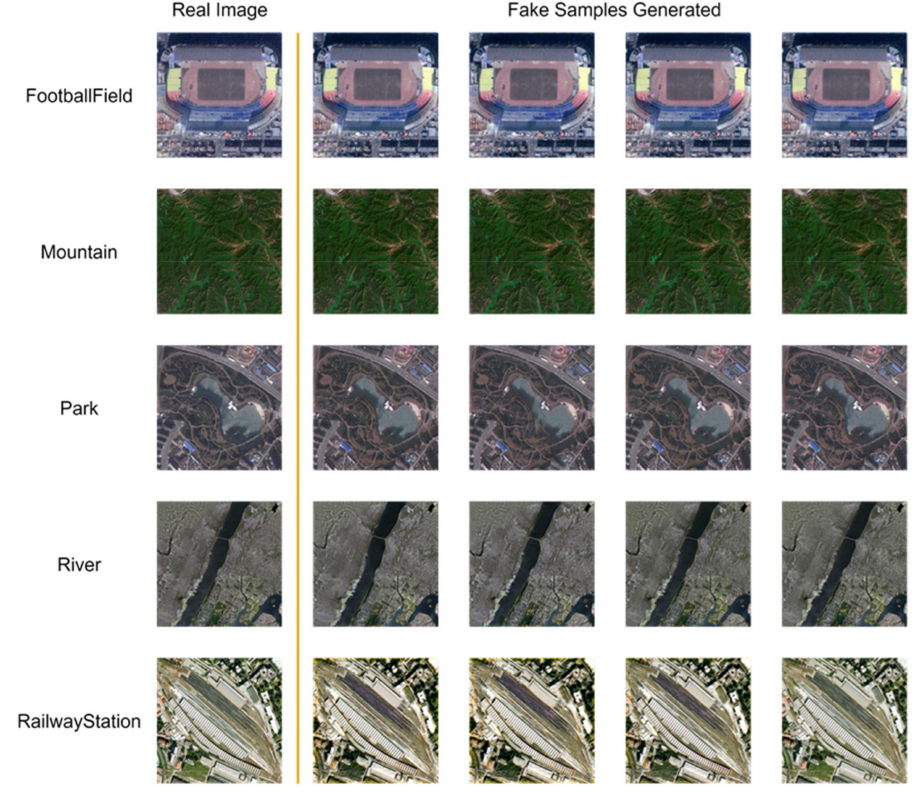
Figure 10. Random remote sensing image fake samples by the improved